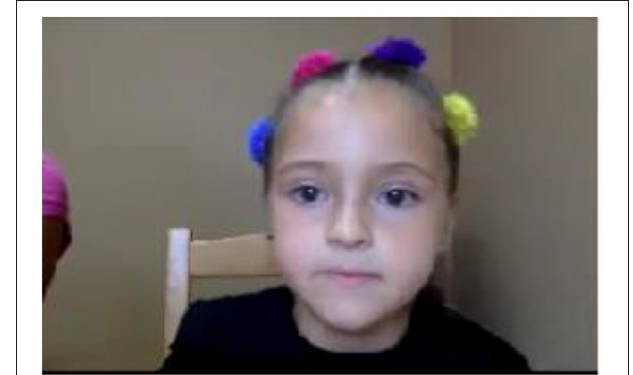
FIGURE 7 | Exemplary video for OpenFace.